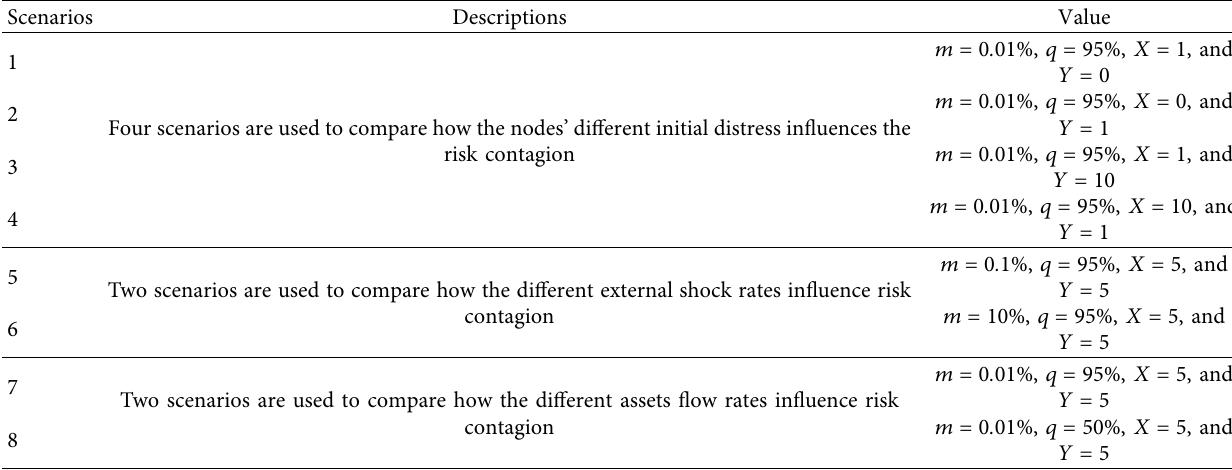
Table 3: Parameters in eight types of scenarios for simulation